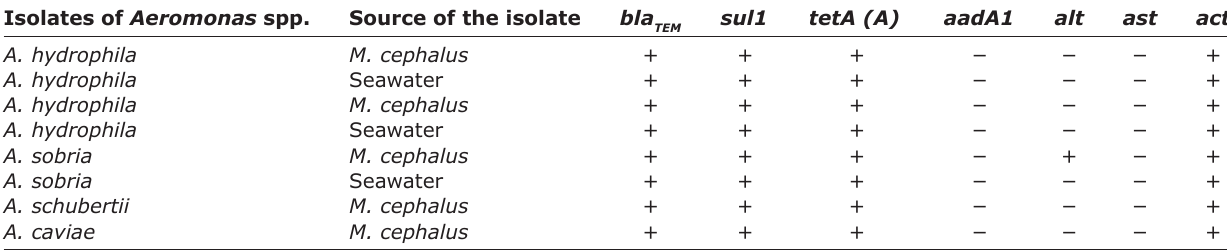
Table-4: Occurrence of antimicrobial resistance genes and virulence genes (enterotoxin genes) among XDR Aeromonas spp. isolates. Isolates of Aeromonas